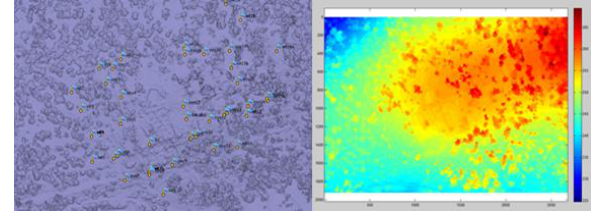
Figure 4: Kimisala site DSM and ground control points For the processing of the data set, PhotoScan from Agisoft has been used. A combined aerial triangulation took place because the pre-signalized targets were only visible in the RGB low height flight. Unfortunately, the targets were washed out because of rain at the previous night before the near infrared flight. The combined automated aerial triangulation using 442 (266 RGB and 176 NIR) photos and 416312 tie points ended with residuals were 0.015, 0.019, 0.036m at X,Y,Z respectively, with an overall 0.928 pixel error. From these block, only the RGB photos were used to extract a dense point cloud with an average of 113 points per square m. Using the DSM (Figure 4) a colour RGB and a NIR orthophoto (Figure 5&6) has been created, with 0.20 m ground pixel size, covering 268x192 m. An equivalent DSM with similar ground pixel size was also exported. Special care was taken so that all outputs cover the exact same area, hence each pixel covers the exact same ground area. In this way, all following processing was made in raster context.